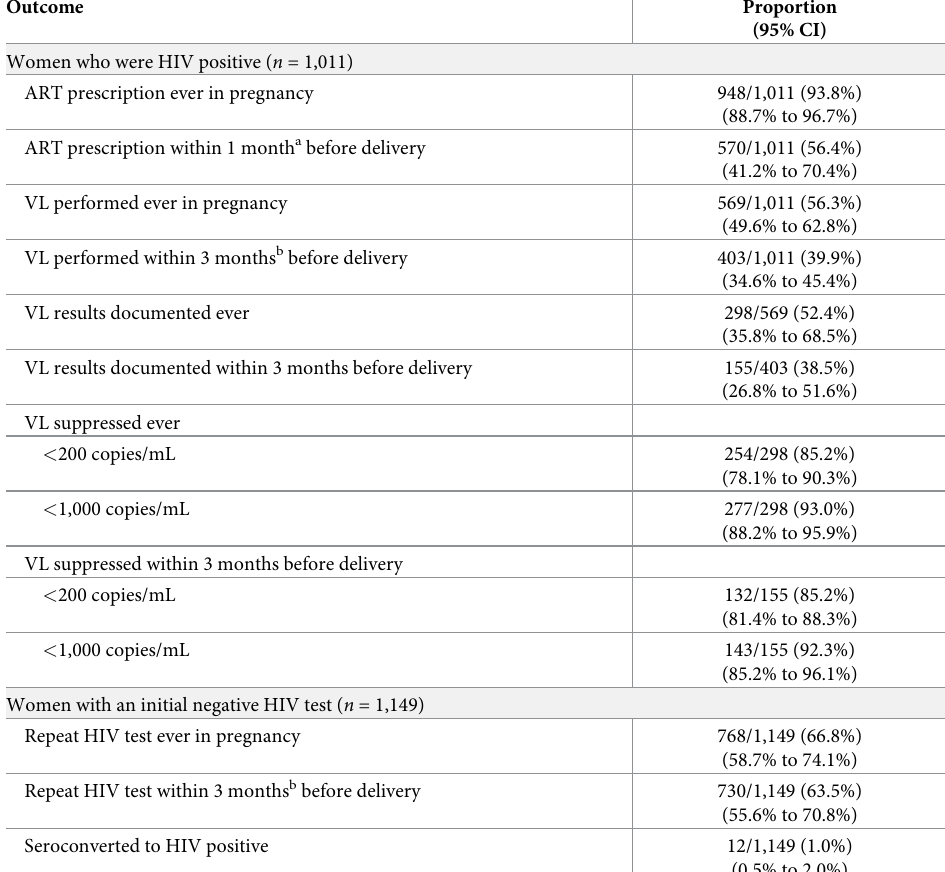
Table 3. Descriptive outcomes aggregated across all